Question: Briefly state, in one sentence, what is plotted here.
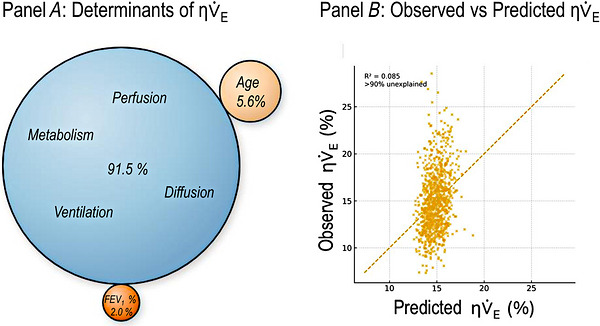
Answer: Determinants and variance explained in η V ˙ E among healthy individuals A , relative contributions of physiological domains to η V ˙ E variance. Structural factors such as FEV 1 _pred (%) and age account for only modest shares of total variability, with most of the variance reflecting integrative physiological determinant. B , relationship between observed and predicted η V ˙ E values from the multivariate regression model ( R 2 = 0.085), illustrating that most of η V ˙ E variability reflects physiological rather than structural factors.